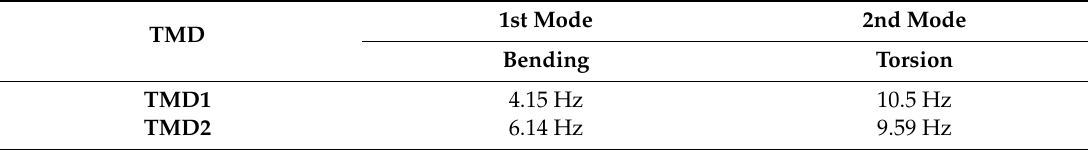
Table 4. Expected modes of 2DOFs TMDs.